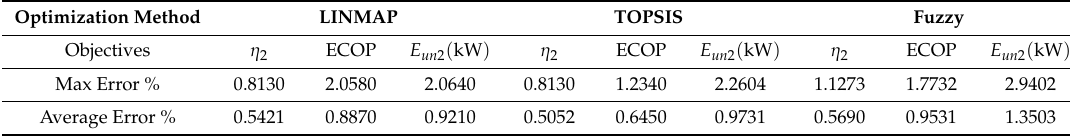
Table 4. Comparative analysis presenting MAPE and